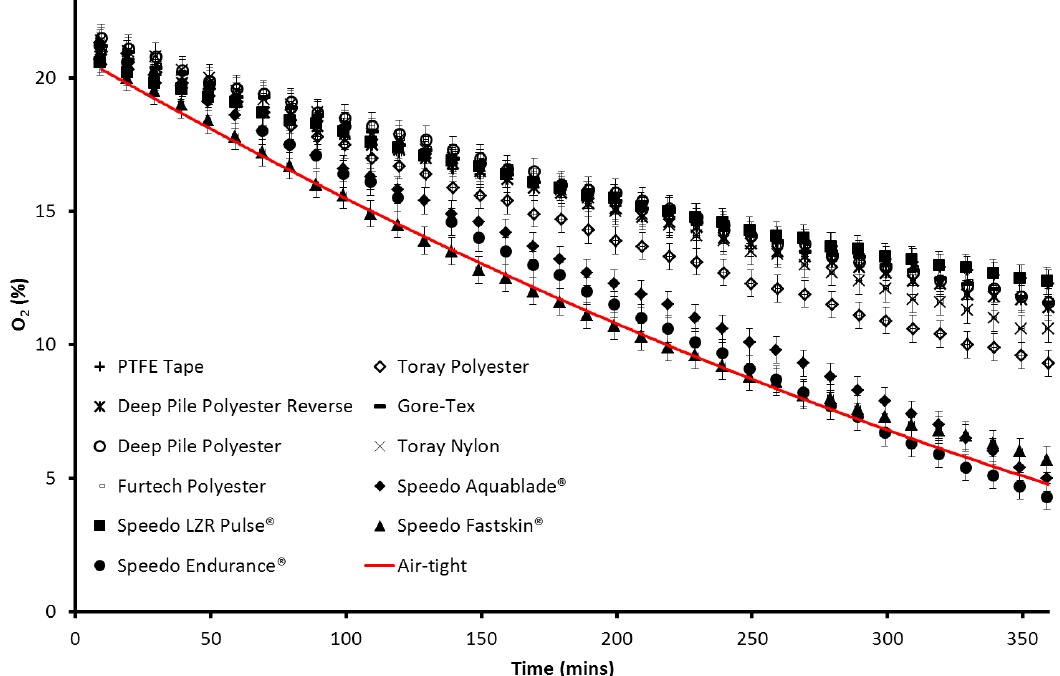
Figure 4. The change in oxygen concentration with time measured with the oxygen meter for the materials tested and for an air-tight container (solid